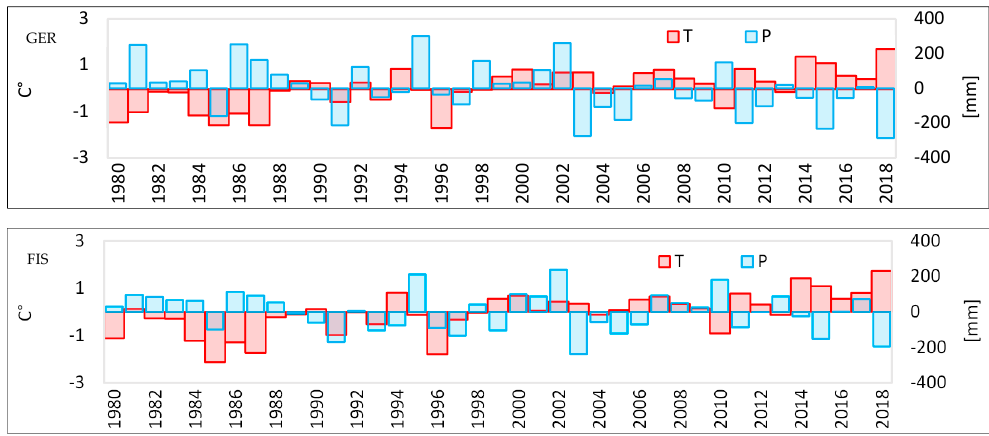
Figure 6. Deviations of annual mean temperatures and annual precipitation to long-term averages in GER ( top ) and FIS ( bottom ): the years 2018, 2015, 2011, and 1991 were identified as exceptionally dry.